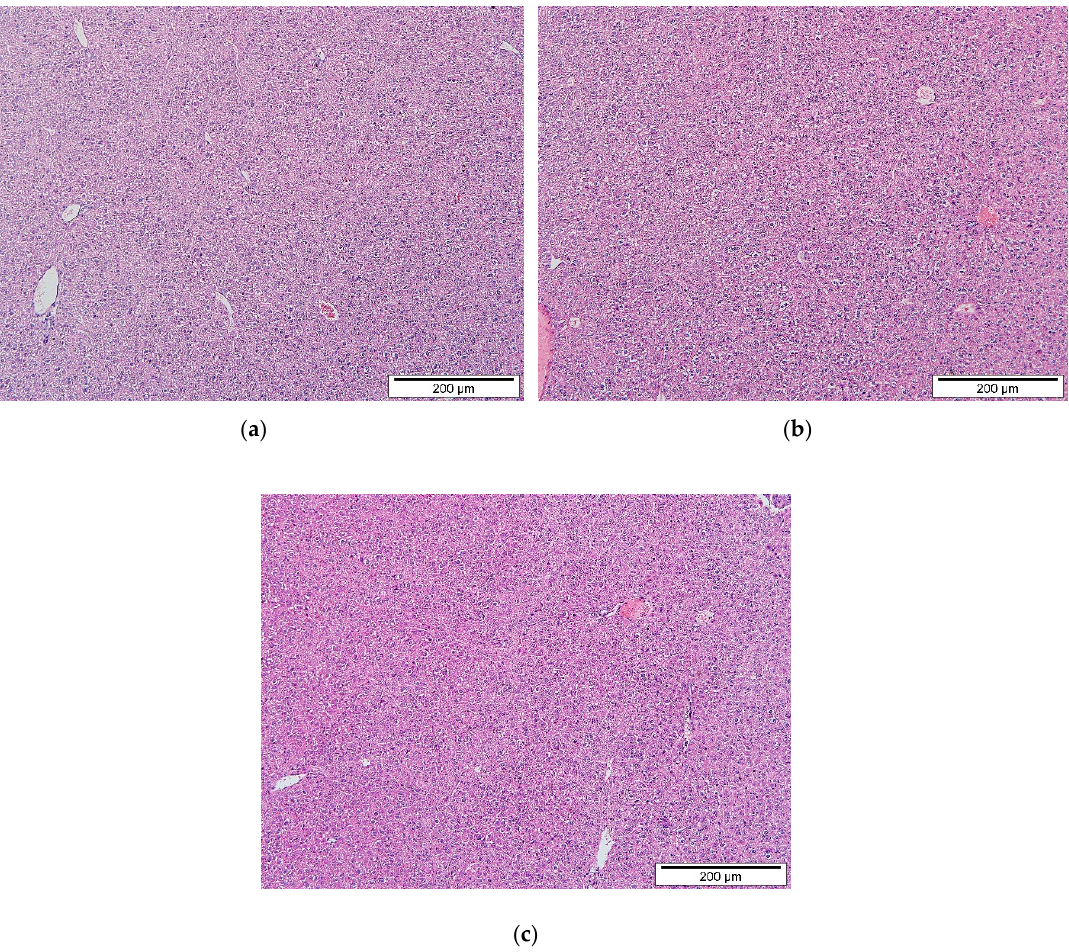
Figure 2. Liver section of: ( a ) control group of mice that received only deionized water; ( b ) 1000 mg / kg of IP 6 -CS-MNPs; ( c ) 2000 mg / kg of IP 6 -CS-MNPs (hematoxylin and eosin (H&E) stain, ×